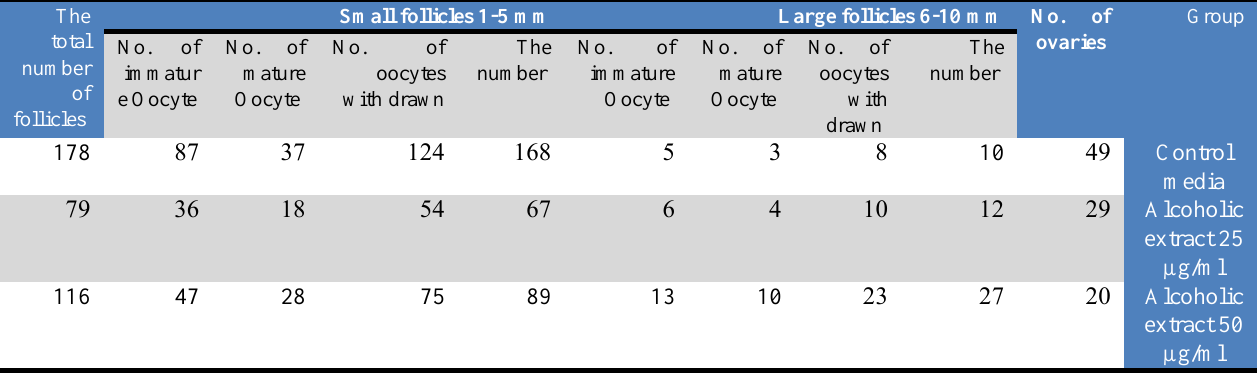
Table 1- Effect of varicose concentration of alcoholic extract of Tribulus terrestris on oocytes maturation .